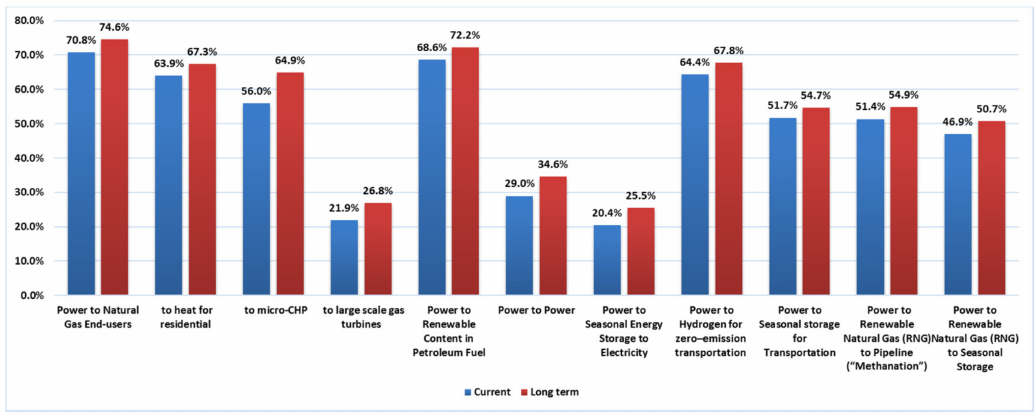
Figure 3. Average current and project energy efficiency of each Power-to-gas (P2G)